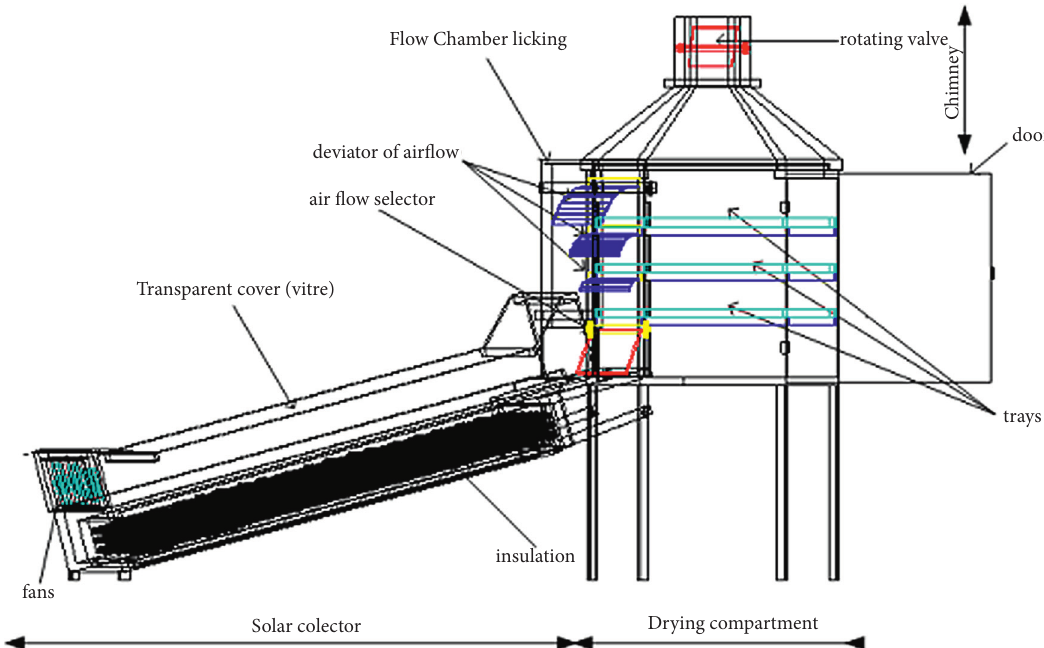
Figure 1: Indirect solar dryer with airflow oriented (ISDAO) [32].